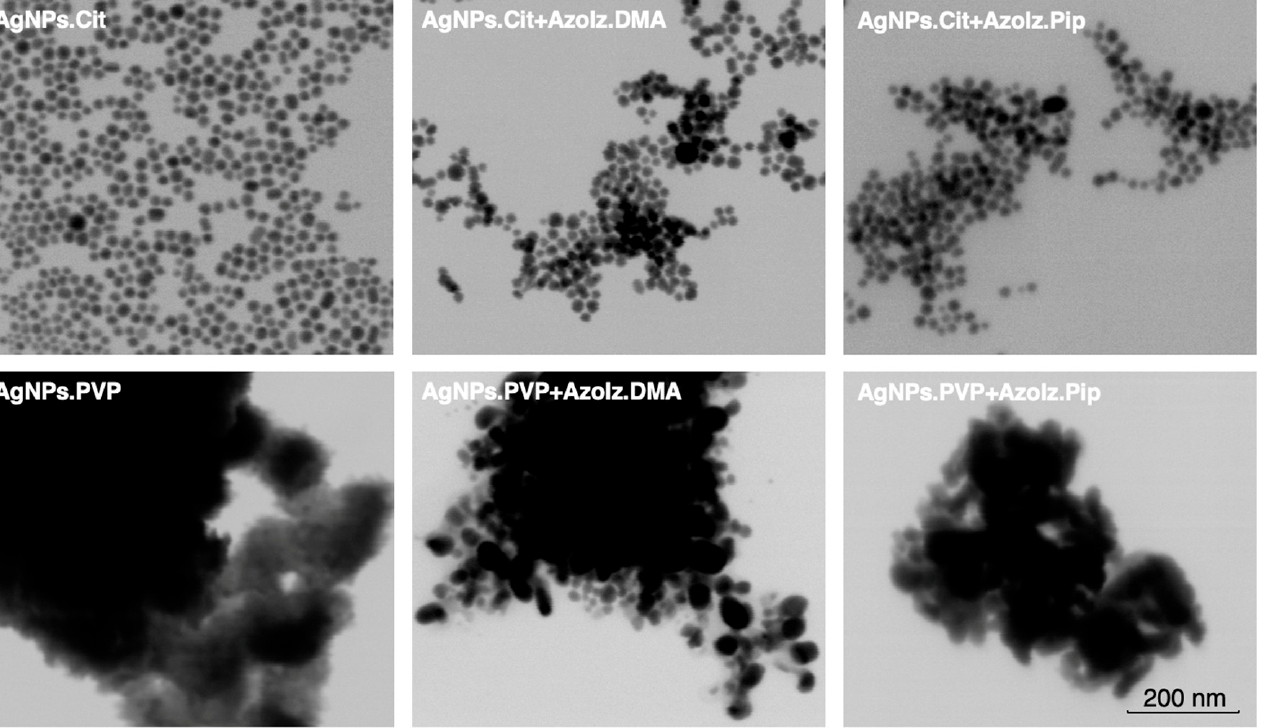
Figure 4. STEM images of AgNPs alone and combined with AzoIz.DMA or AzoIz.Pip at a magnification of 400,000x. Table 1. Size, PdI, and zeta potential values of AgNPs.Cit or AgNPs.PVP alone, in a concentration of 25.0 µ g · mL − 1 , and conjugated with organic molecules in two different concentrations (16 µ g · mL − 1 and 32.0 µ g · mL − 1